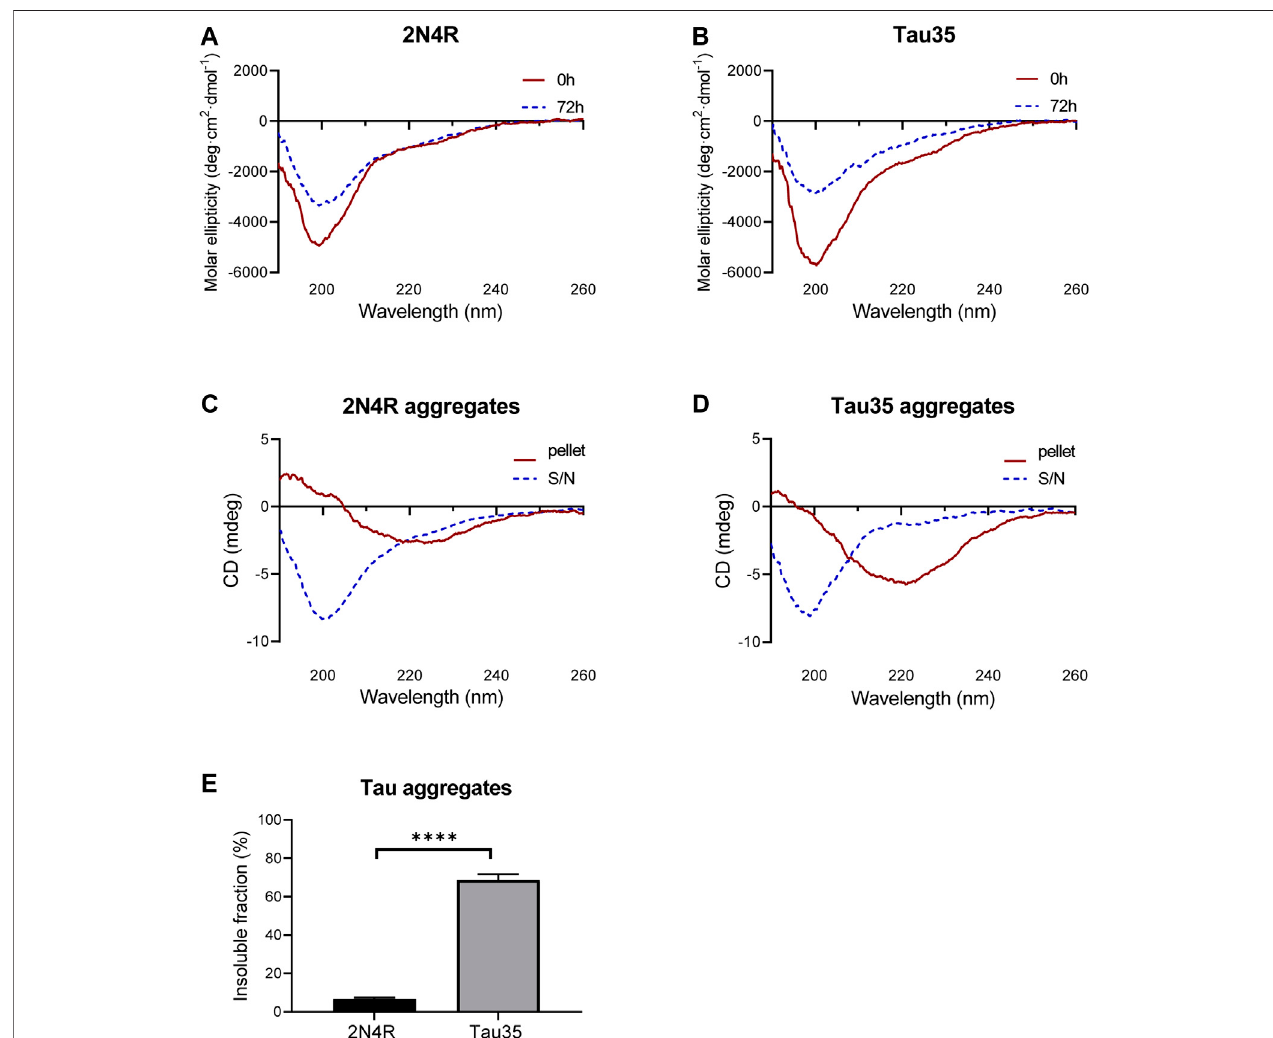
FIGURE4| Secondarystructure of2N4R tauand Tau35heparin-induced aggregation.CD spectra obtained from (A) 2N4R tau and (B) Tau35in 10 mM PBS,pH 7.4followingaggregationinthepresenceofheparinandDTTfor0h(red)or72 h(blue)at20 ° C. (C,D) CDspectraofthesamesamplesaftercentrifugationtoseparateout the aggregated (pellet, red) from the soluble (S/N, blue) protein. Note that the y axis annotation in C,D is in mdeg rather than Θ because it is not possible to accurately estimate the protein concentration of these samples. (E) Graph showing the percentage of aggregated tau relative to starting material, following heparin-induced aggregation of 2N4R tau and Tau35 for 72 h at 37 ° C. Bars indicate mean ± SEM, n (cid:2) 3, **** p < 0.0001, Student ’ s